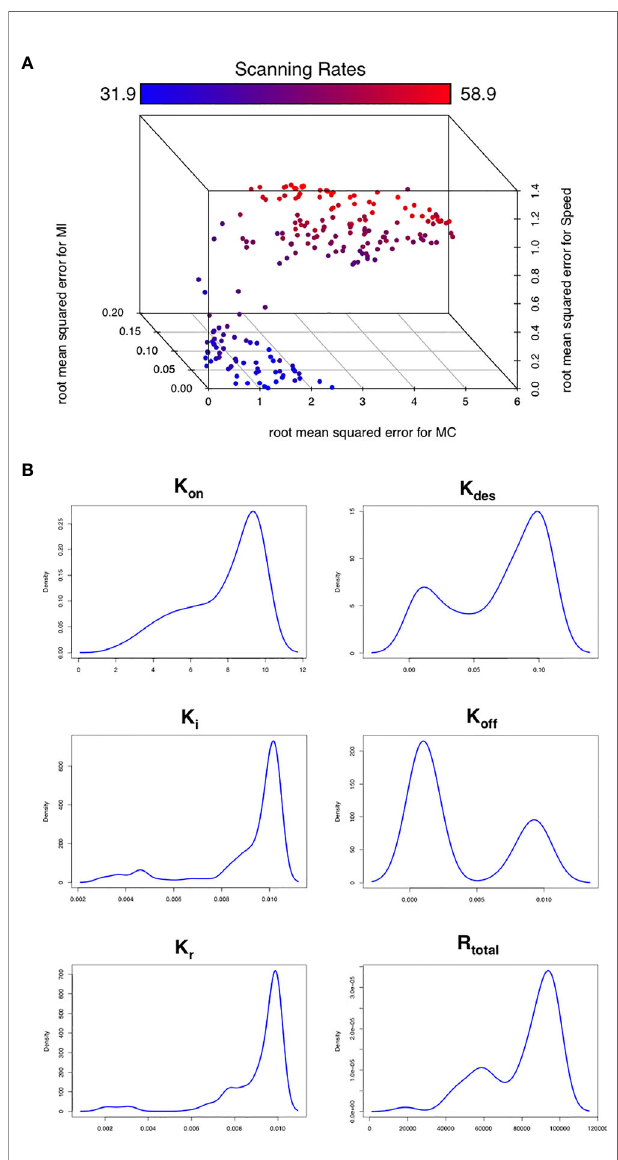
FIGURE 3 | Optimizing CXCR5 signaling in silico . (A) Pareto front of solutions representing the optimal trade off in performance between different in silico migratory behaviors and scanning rates (color coded), using the multiobjective optimization algorithm NSGA-II. (B) Parameter distributions corresponding to the Pareto optimal solutions shown in (A)